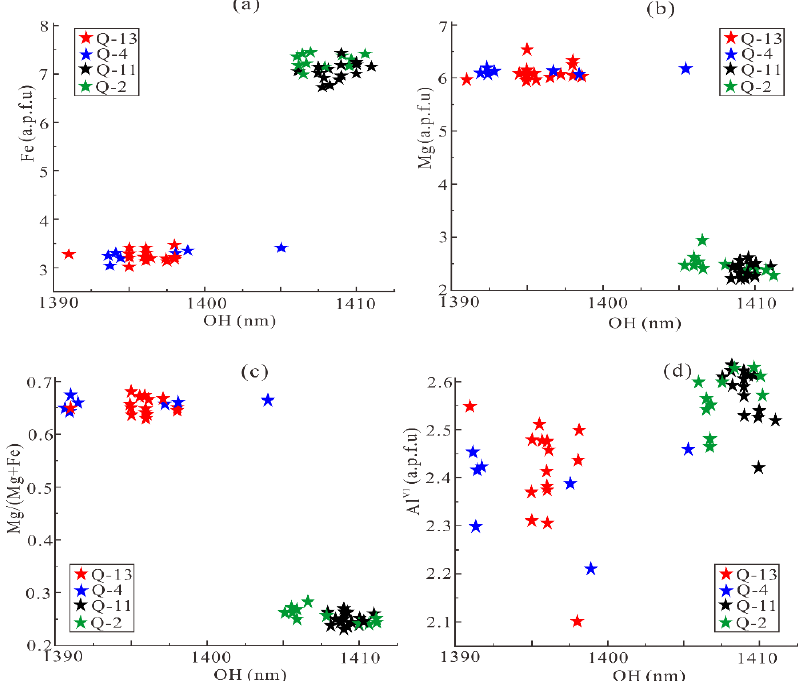
Figure 22. The relationship between the wavelength of OH band and the content of cations in the octahedral layer of chlorite: (( a ) the relationship between OH and Fe; ( b ) the relationship between OH and Mg; ( c ) the relationship between OH and Mg/(Mg + Fe); ( d ) the relationship between OH and Al VI (the overlap points have been offset for clarity)).